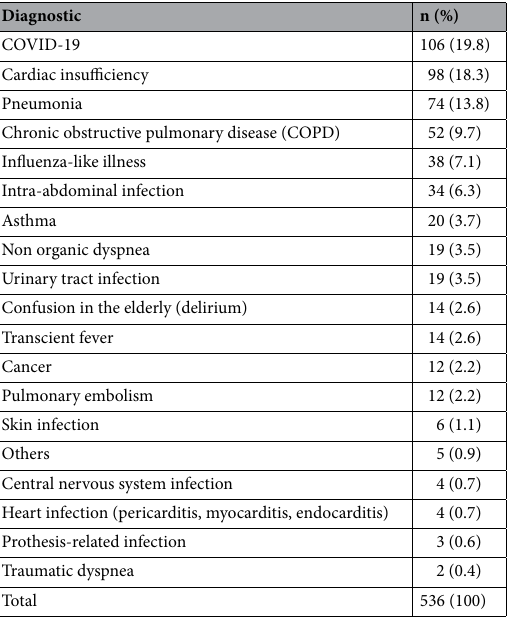
Table 1. Diagnostic categories for the 536 suspected COVID-19 hospitalized patients. All patients presented at last one clinical sign compatible with COVID-19 and underwent chest-CT and RT-PCR. 106 were classified in the COVID group, 430 in the NOT-COVID